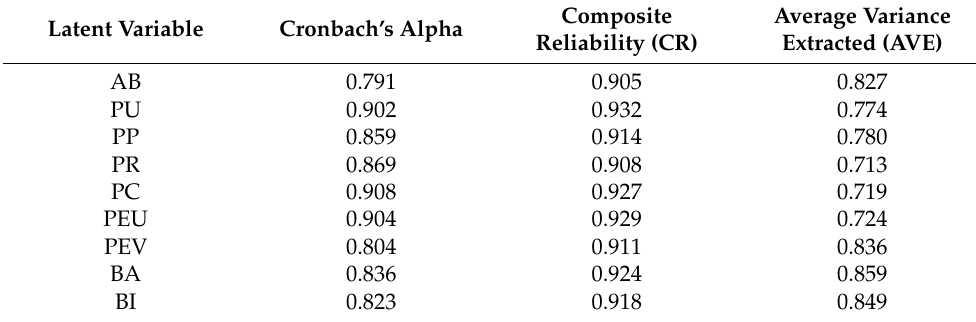
Table 5. Measurement model